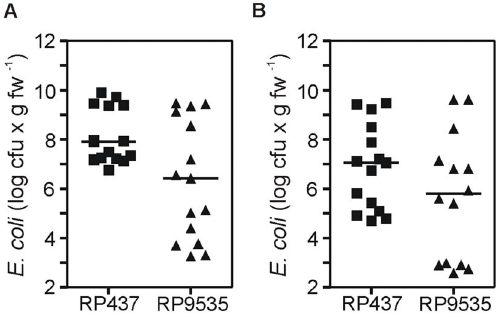
Figure 7. Effect of disrupting the chemotactic response of Escherichiacoli on the bacterial colonization of lettuce seed- lings. (A–B) E. coli colonization of lettuce seedlings (A) roots or (B) leaves after inoculation with non-adapted strains RP437 or PR9535. The bars represent the median value of the datasets.